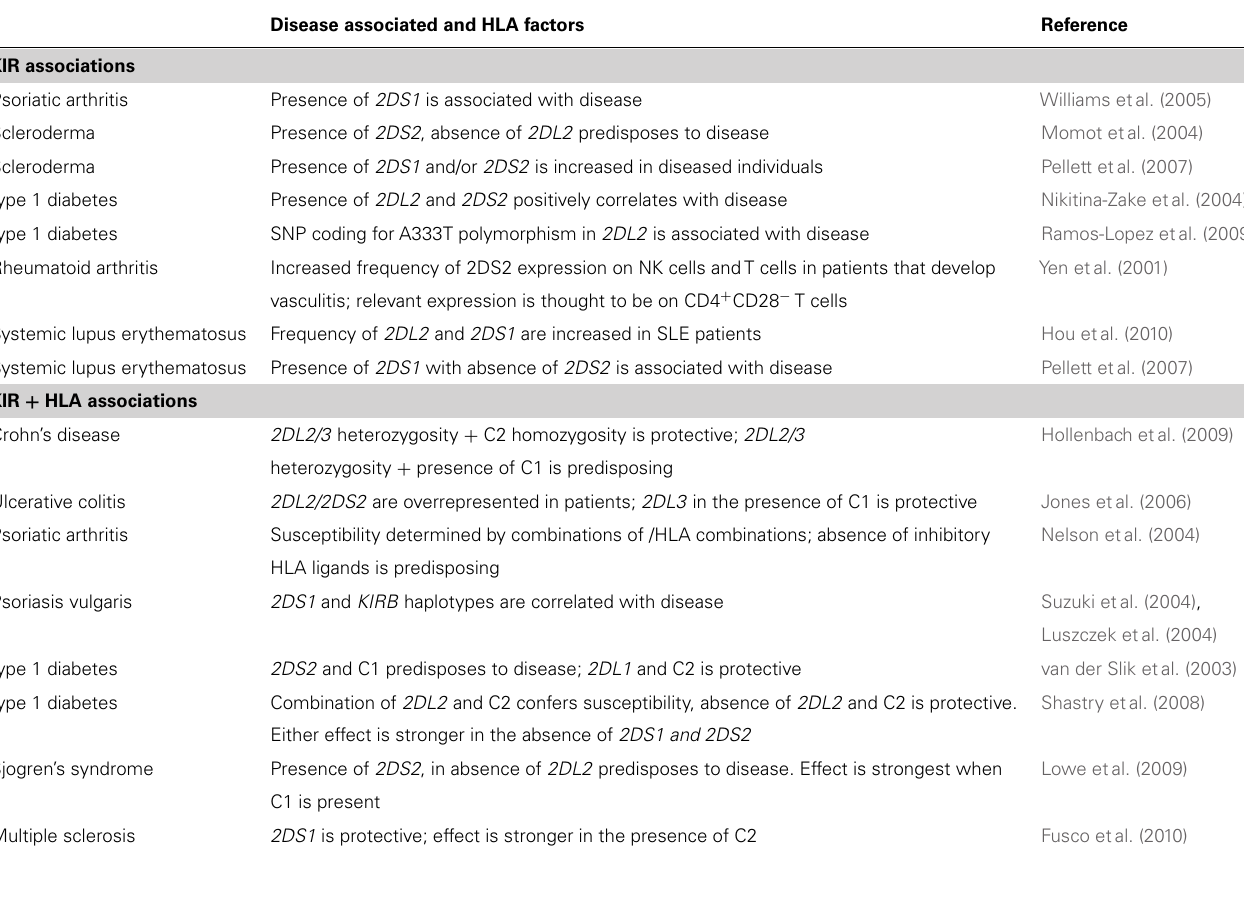
Table 7 |Associations of KIR2DL2/3 with autoimmune